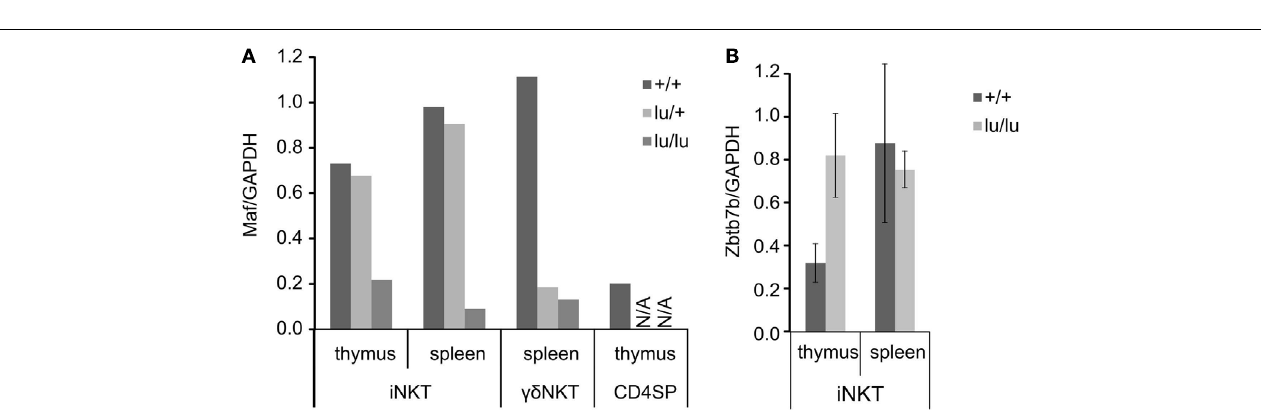
antibodies againstTCR β , CD24, CD44 and NK1.1. iNKT, γδ NKT or CD4 single positive were sorted, mRNA was extracted, and subjected to RT-PCR. Error bars represent SD from independent